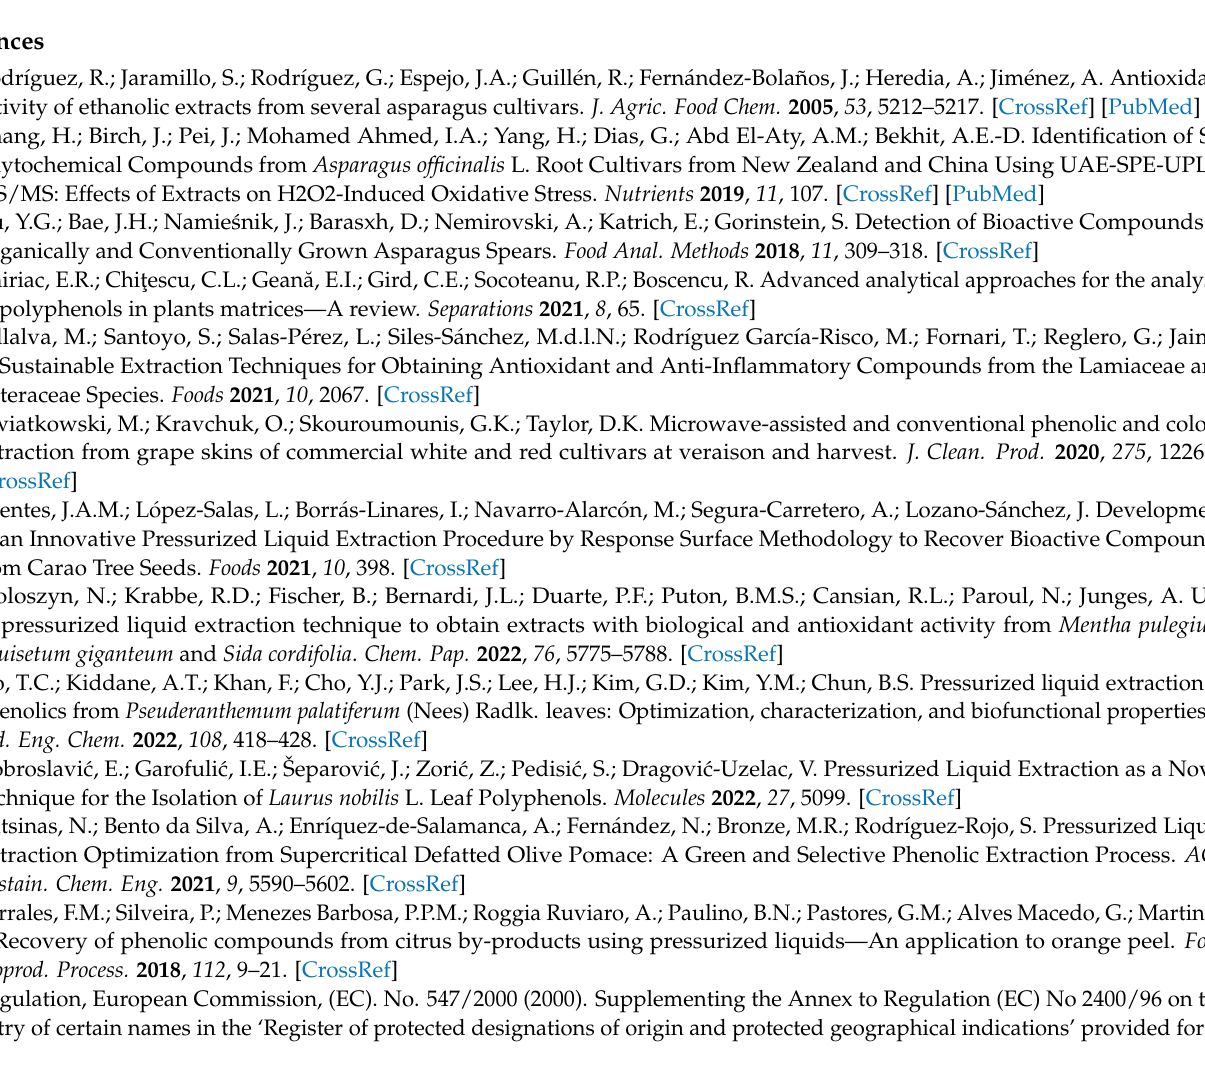
surized fluid extraction. Table S2: Calibration parameters. Table S3: Extraction yield of different PLE experiments (1–25) and SLE extraction. Table S4: Total and individual contents of phenolic compounds from the PLE and SLE extracts. Values are expressed as X ± SD in mg of compound/g